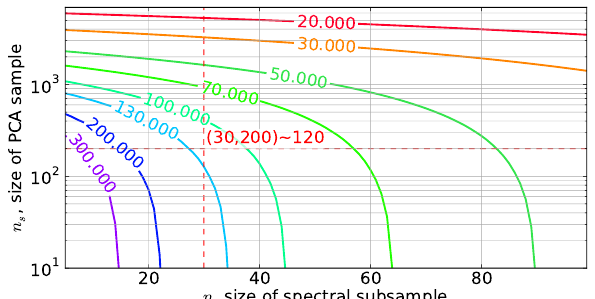
Fig. 13. Shown are lines of constant speedup using the presented technique for the lookup-table-like problem as defined in Table 1. The speedup is presented as a function of the size of the chosen spectral subsample and the size of the state space subsample used for the computation of the principal components. Equation (8) was used to create the figure and the speedup for n = 30 and n s = 200 is highlighted.